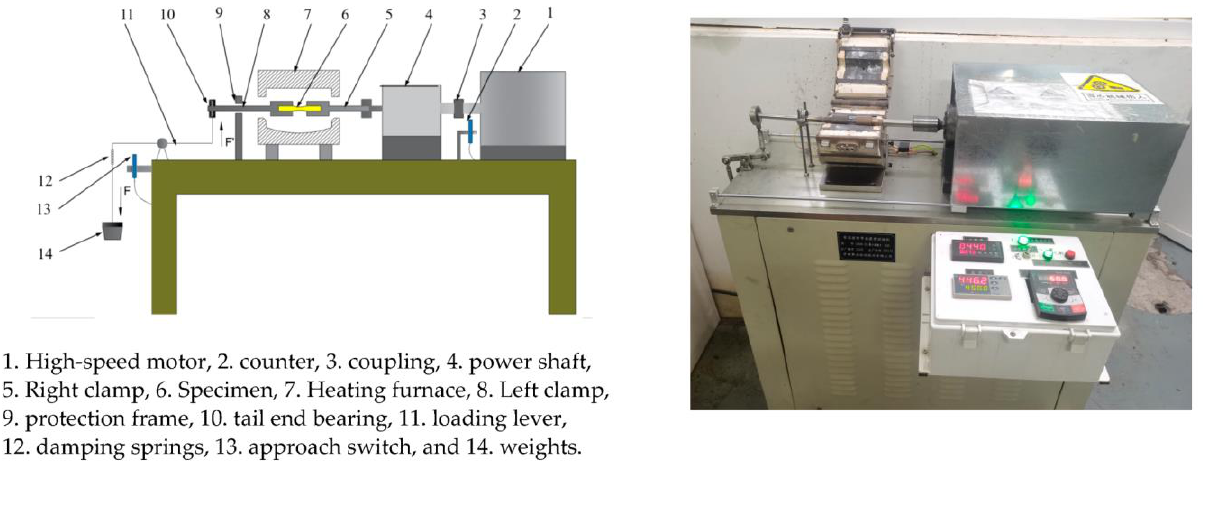
Figure 5. High-temperature rotating bending fatigue machine. ( a ) Schematic diagram and structural compositions of high-temperature rotating bending fatigue machine; ( b ) high-temperature rotary bending fatigue testing machine physical picture.